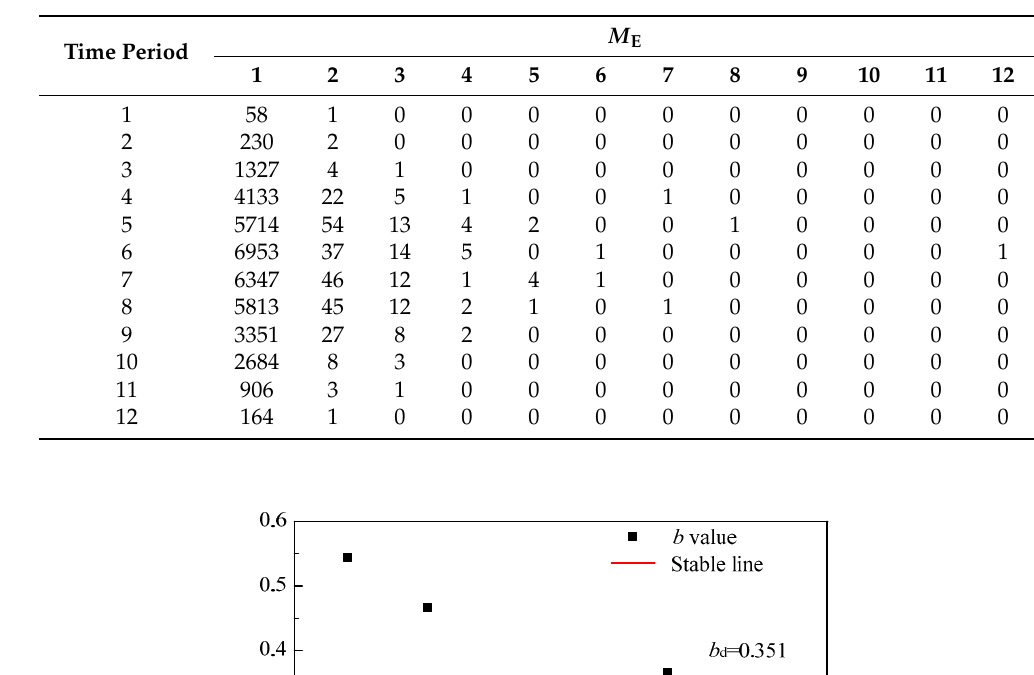
Table 2. Statistical results of N E for each time period.